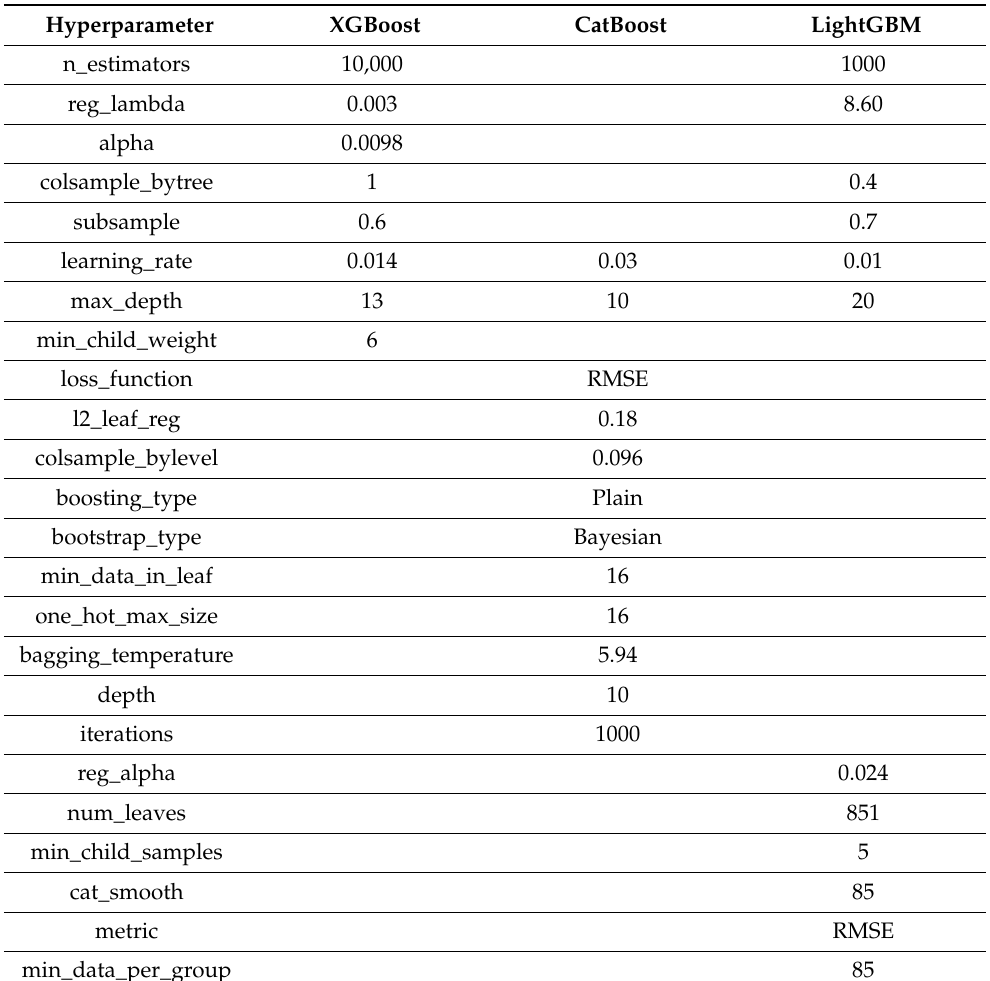
Table 1. The optimum hyperparameter values for the XGBoost, CatBoost and LightGBM models trained on the normal